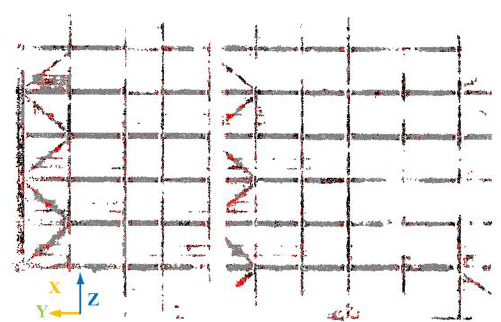
Figure 16. Classification result of real photogrammetric point cloud.